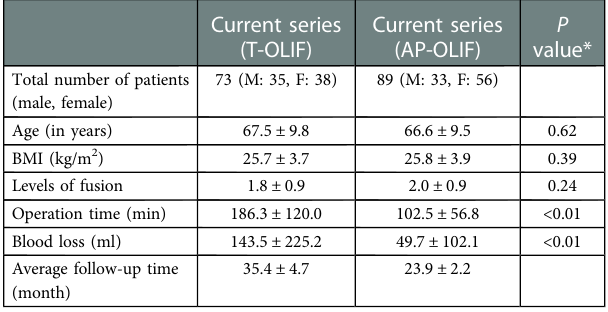
TABLE 1 Patient